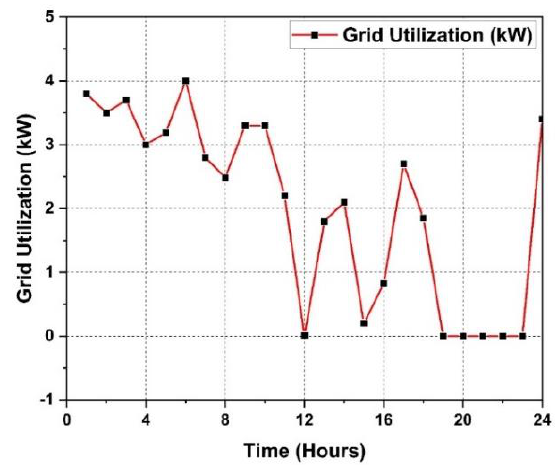
Figure 3. Grid utilization to load (off− grid).